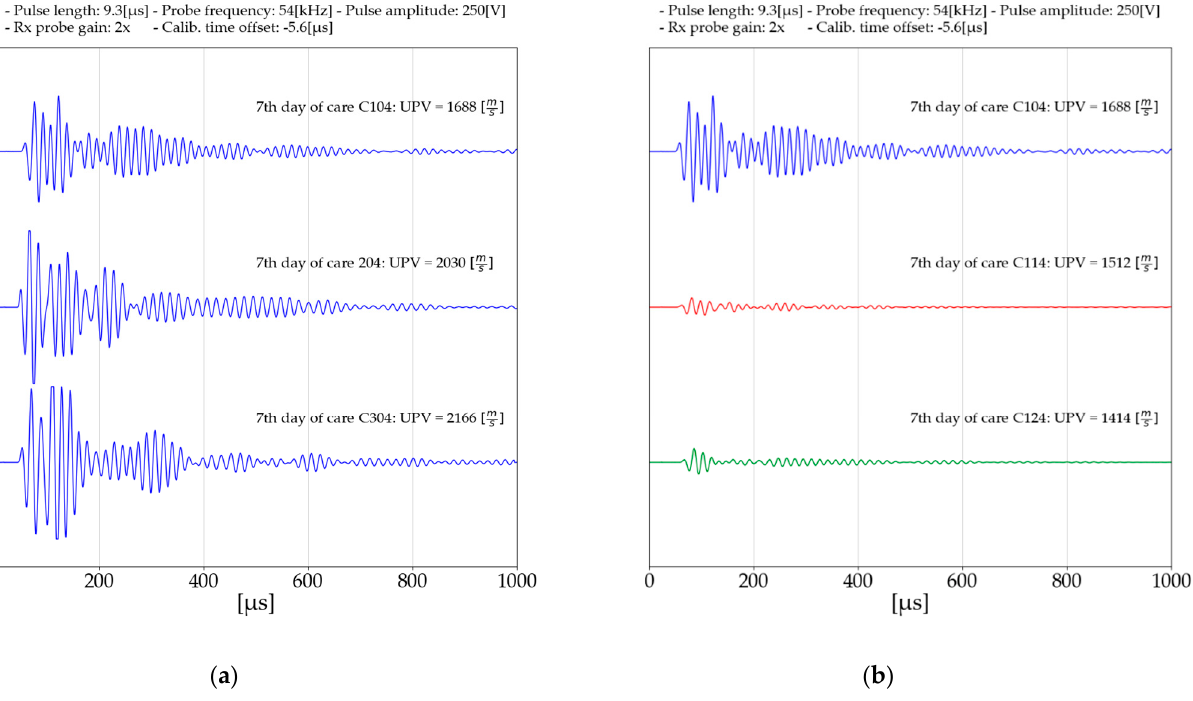
( d ) Figure 6. Received waves during Ultrasonic pulse velocity test—day 7 of curing period: ( a ) Mixtures without polypropylene fibers; ( b ) mixtures with 3% binder; ( c ) mixtures with 5% binder; ( d ) mixtures with 7% binder. By using a material that is more ductile than the soil-cement matrix, it creates a softer region along the wave travel path, constantly reducing the energy of the wave [51]. A similar effect has been observed by other authors during bender element testing [52], as well as with ultrasonic pulse velocity ( UPV) testing [51]. The phenomenon is indirectly related to the change in density of the soil matrix of the binder and fibers. This density decreases as a result of the applied reinforcement. This is caused by the replacement of